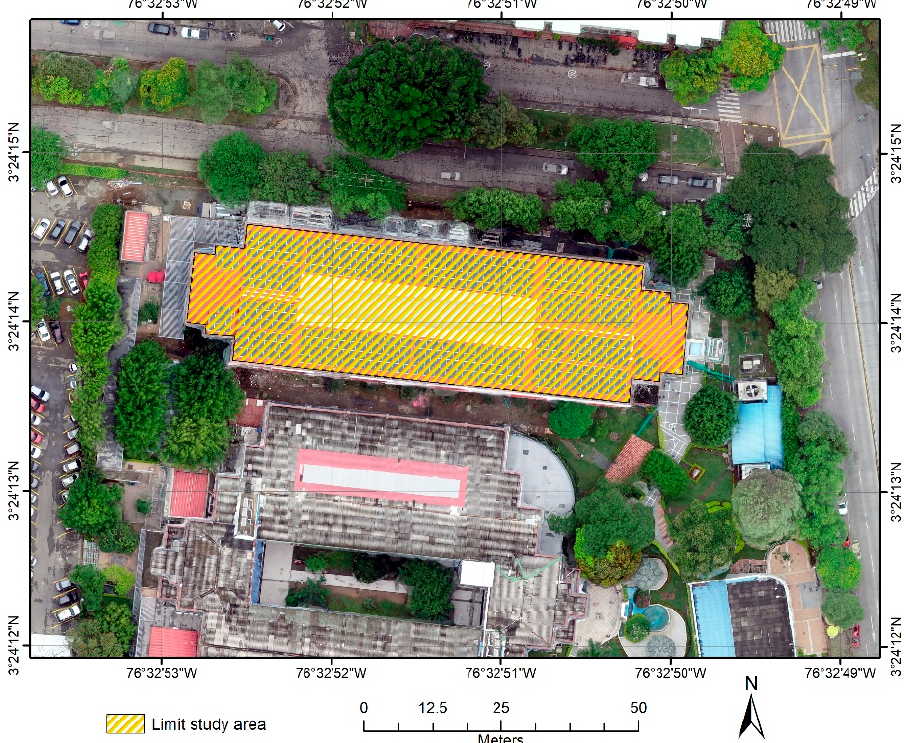
Figure 2. Location of study area, Santiago de Cali University.